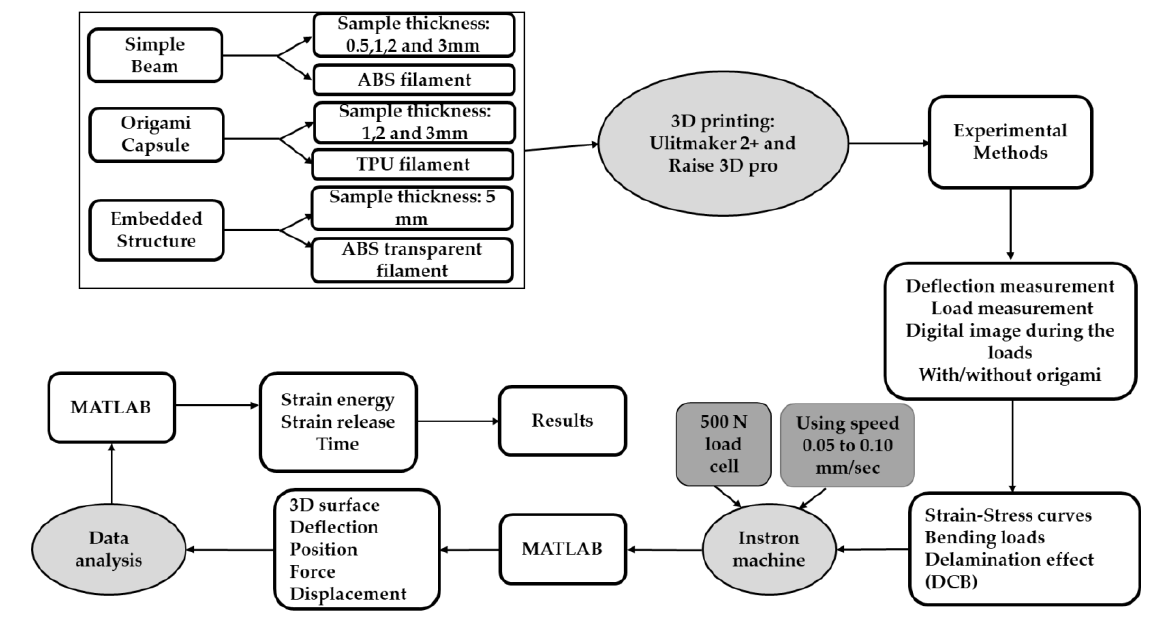
Figure 1. Methodology diagram.